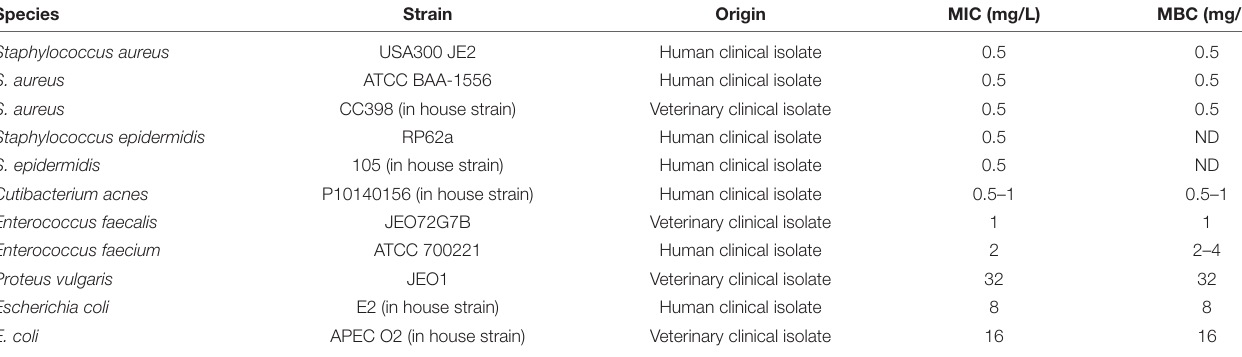
TABLE 1 | Broth microdilution results for JBC